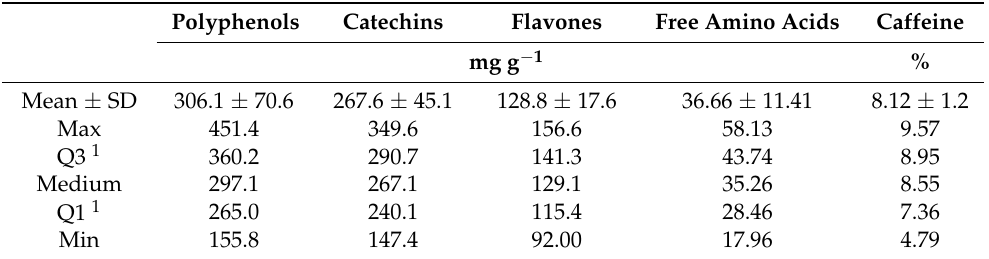
Figure 2. Visualization comparison of the concentration of ten foliar elements (n = 20). The unit of macronutrients was converted into mg kg − 1 . Table 3. The basic descriptive statistics of chemical compositions in tea leaves. (n =